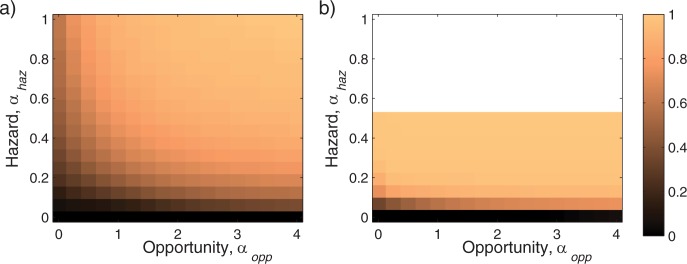
Influence of opportunistic and hazardous coefficient on the steady-state population distribution.Mean capacity that is selected as function of the opportunistic coefficient, αopp, and the hazardous coefficient, αhaz for fixed-cost coefficient, αfix = 1 (a) and αfix = 0.5 (b). The graphs demonstrate that hazard is more influential in selection of high glycolytic capacity than opportunity